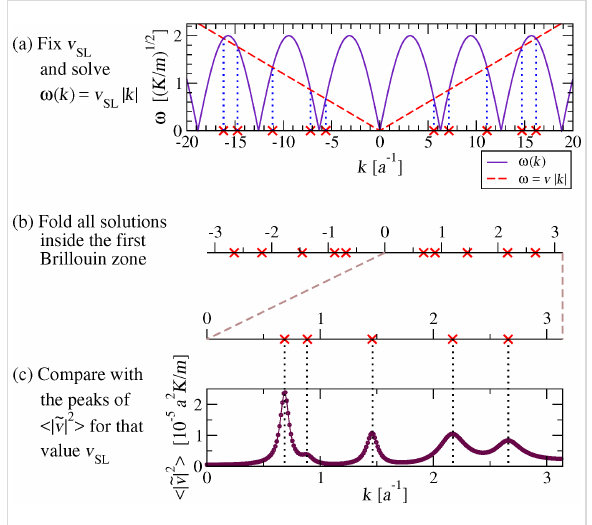
Figure 12: A scheme of the steps performed to identify the phonons whose phase velocity equals v SL , and the comparison of the obtained wave vectors with the observed excited phonons peaks for the same slider velocity v SL . In this example v SL = 0.12 v s .